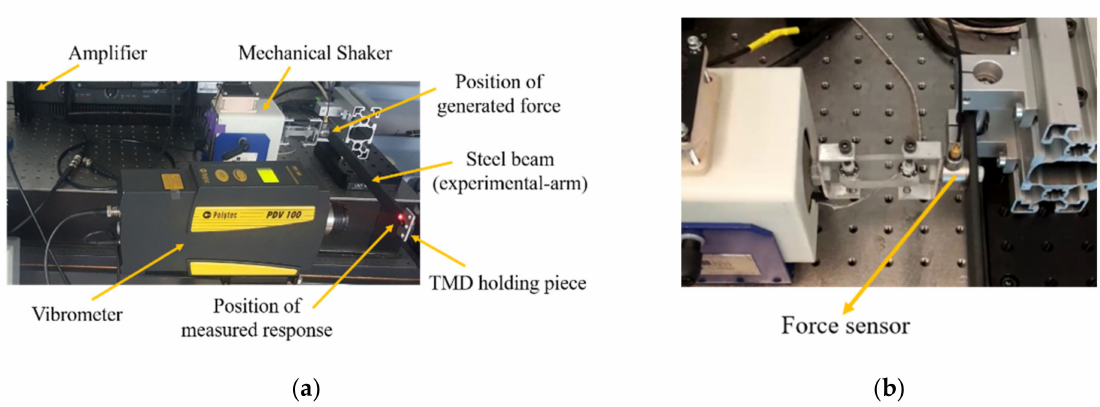
Figure 1. ( a ) Experimental setup used to test the behavior of the TMD system with realistic tremor signal; ( b ) connection between the mechanical shaker and the experimental